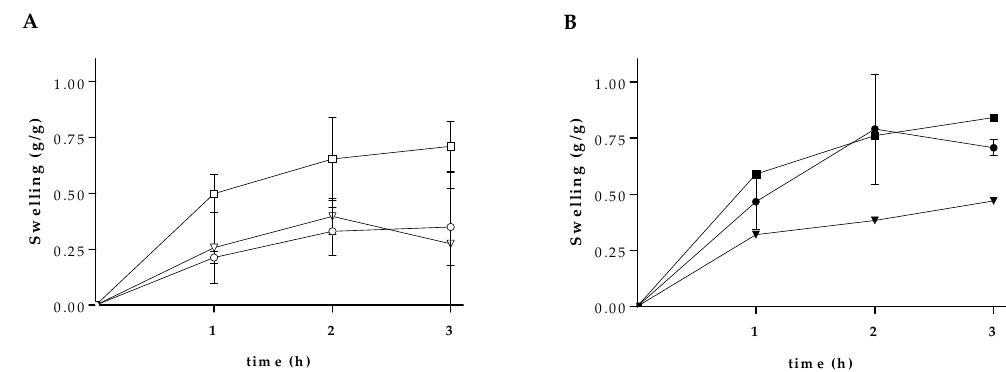
Figure 2. Swelling ratio of SA-PVA hydrogels. 1/1 (circle), 2/1 (square), and 1/2 (inverted triangle) empty hydrogels ( A ) and quercetin-loaded hydrogels ( B ) were soaked in water up to 3 h.